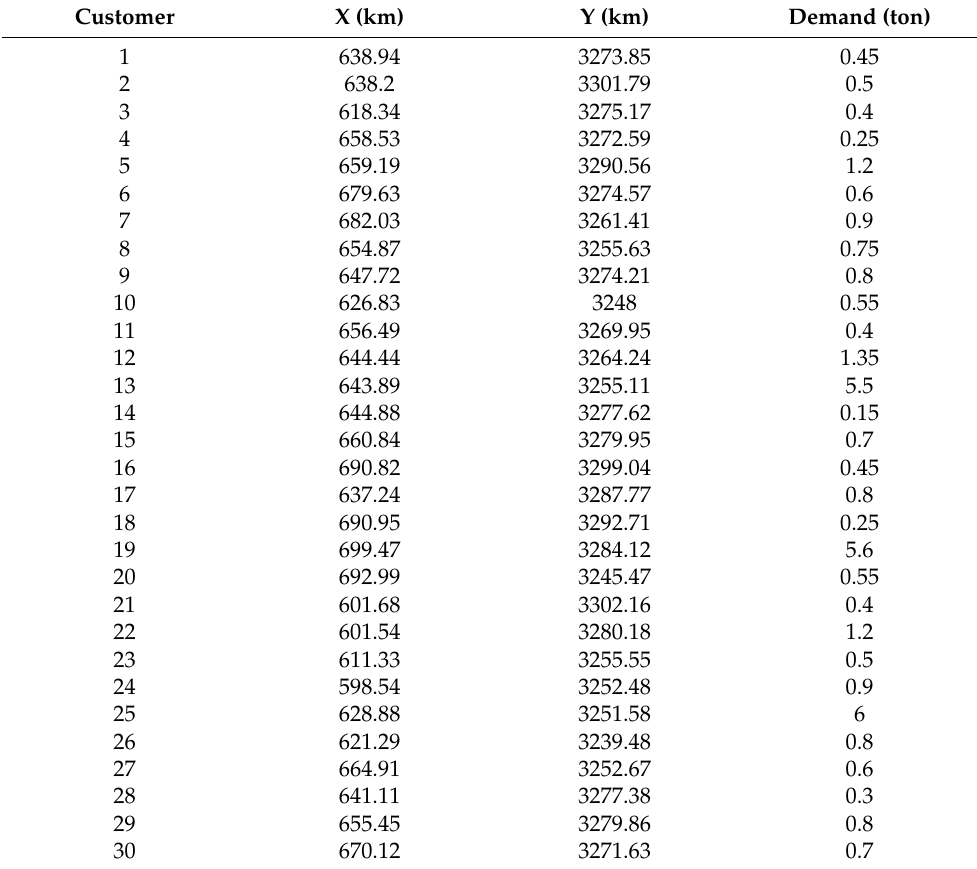
Table 4. The customer data.